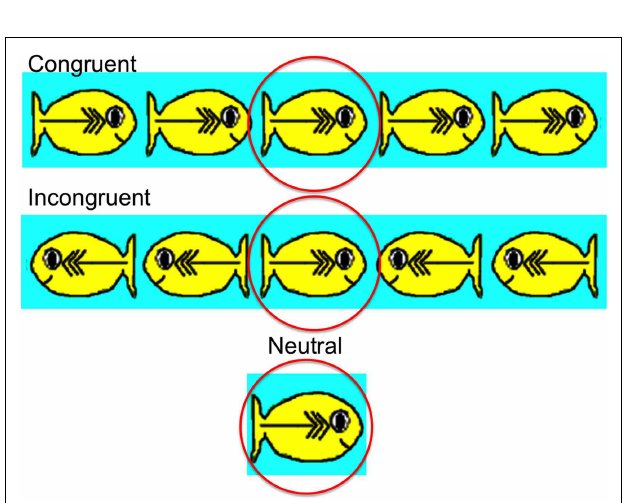
FIGURE 10 |The attentional network test (ANT) presentation inYoshida et al. (2011). The target “hungry” fish are circled in